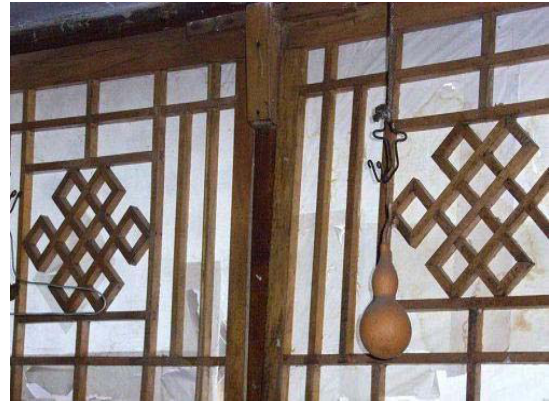
Figure 5. Indoor image of a rice pulp window [8].